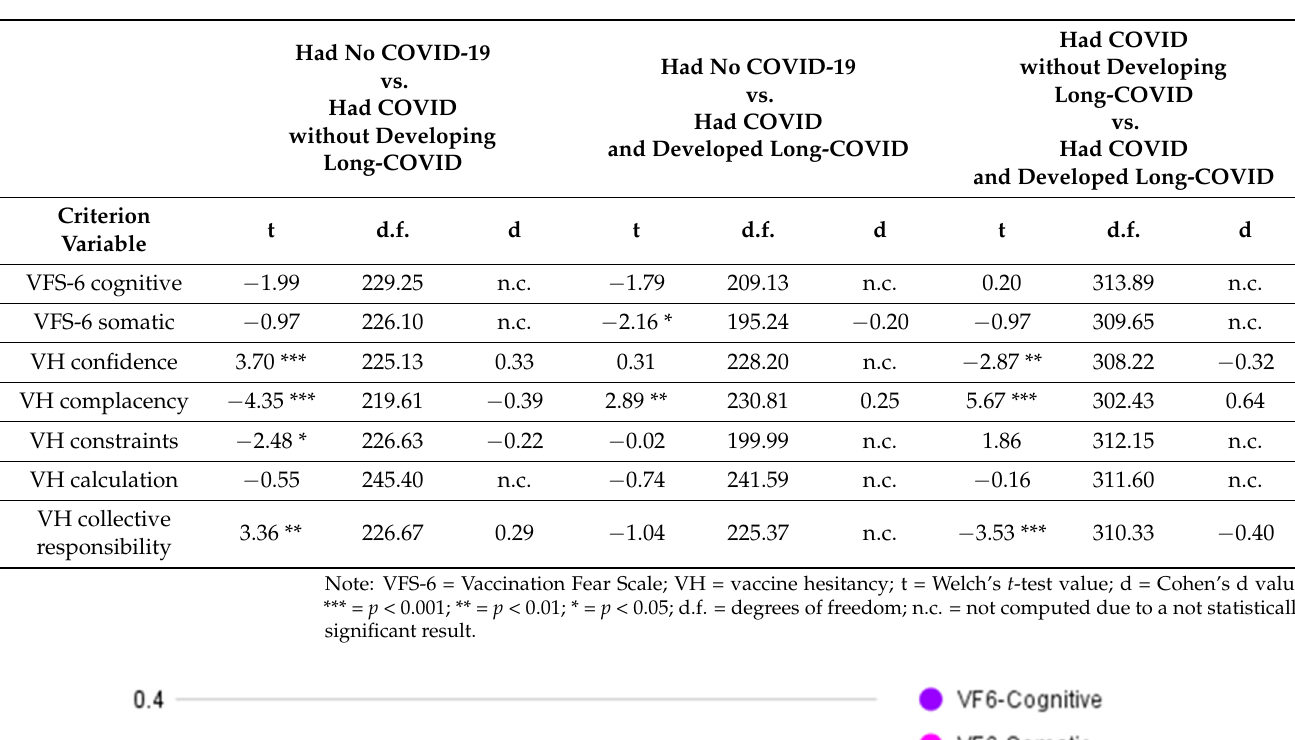
Table 3. Pairwise comparison through Welch’s t -test.